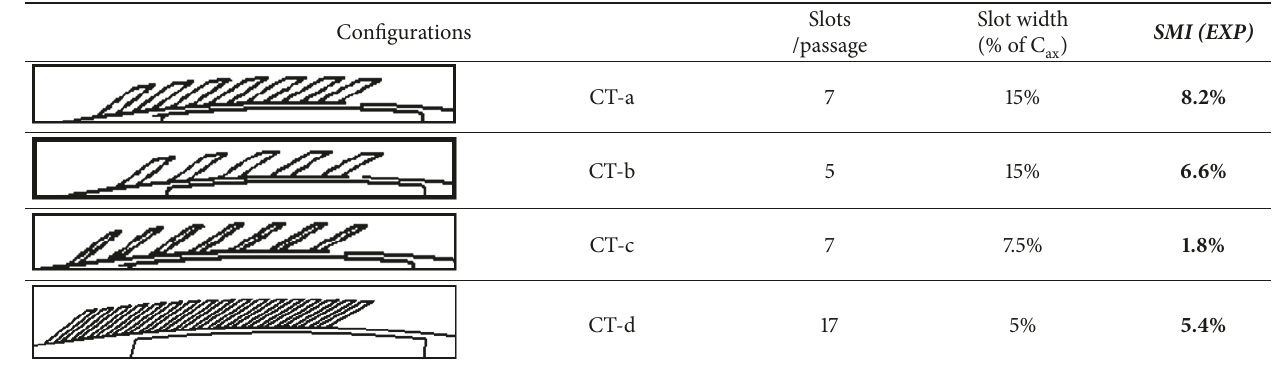
Table 1: The effectiveness for different axial slot schemes.